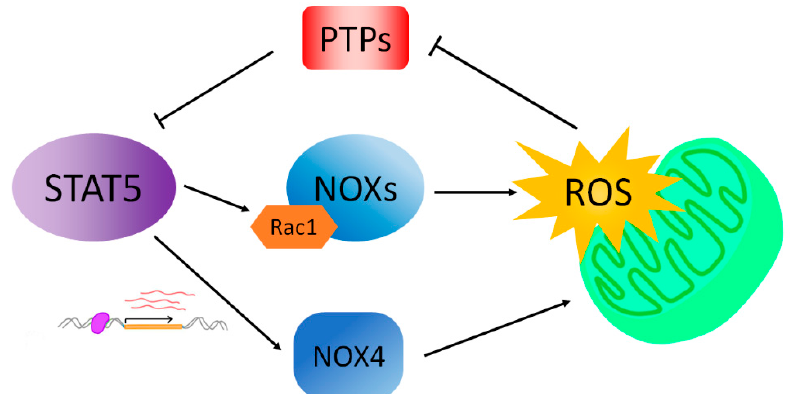
Figure 2. STAT5 cooperates with reactive oxygen species (ROS) in a feedforward and feedback manner. Close connections between STAT5 and ROS provide leverage for therapeutic targeting. Inhibition of ROS permits liberation of inhibitory phosphatases which remove the phosphate from activated STAT5 thus causing de-activation.